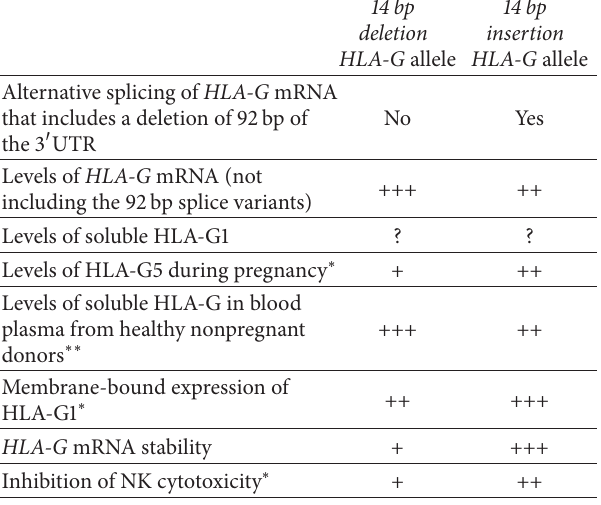
Table 1: A comparison of differences in HLA-G gene and protein expression and functional characteristics between the 14bp dele- tion and 14 bp insertion alleles. The observed differences may be influenced by other DNA and mRNA polymorphisms in the 3 󸀠 - untranslated region (3 󸀠 UTR), especially the +3142 and +3187 SNPs, and/or the 5 󸀠 -upstream regulatory region of HLA-G that are in linkage disequilibrium with the 14bp ins/del polymorphism (see the text and Figure 1 for details). (Based on a large number of references listed in the